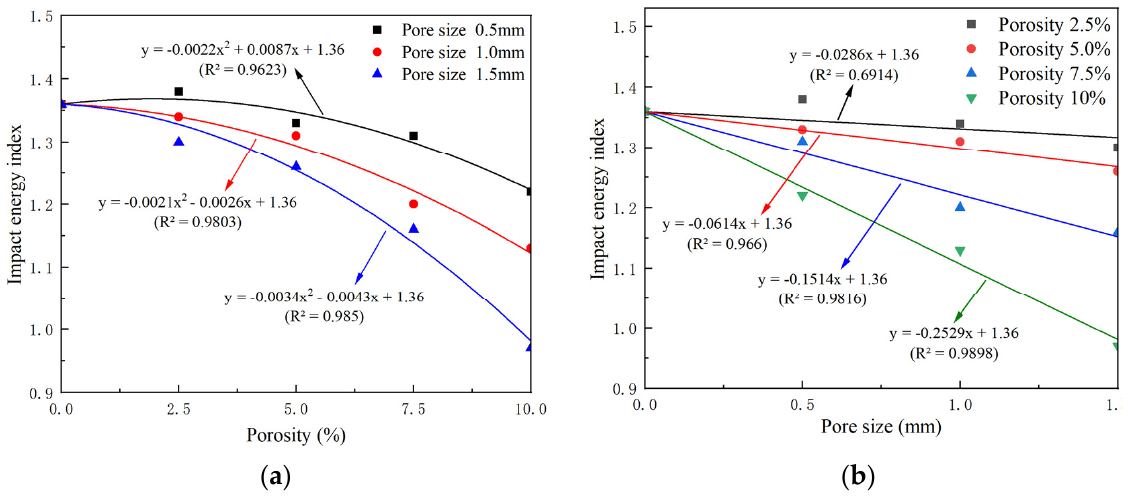
Figure 13. The coal rock model impact energy index and pore size fitting curve. ( a ) Impact energy index-porosity fitting curve. ( b ) Impact energy index-porosity fitting curve.